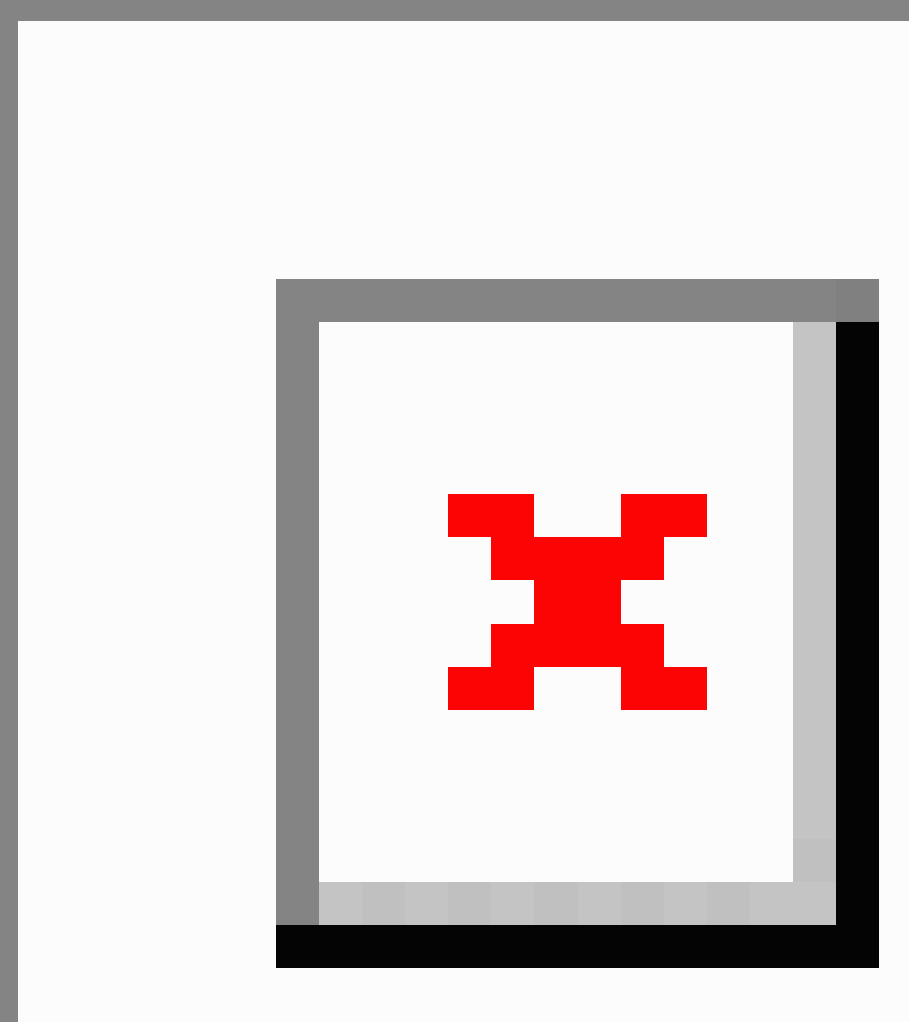
Figure 2. Michael's morning ritual represented in a Markov Chain.